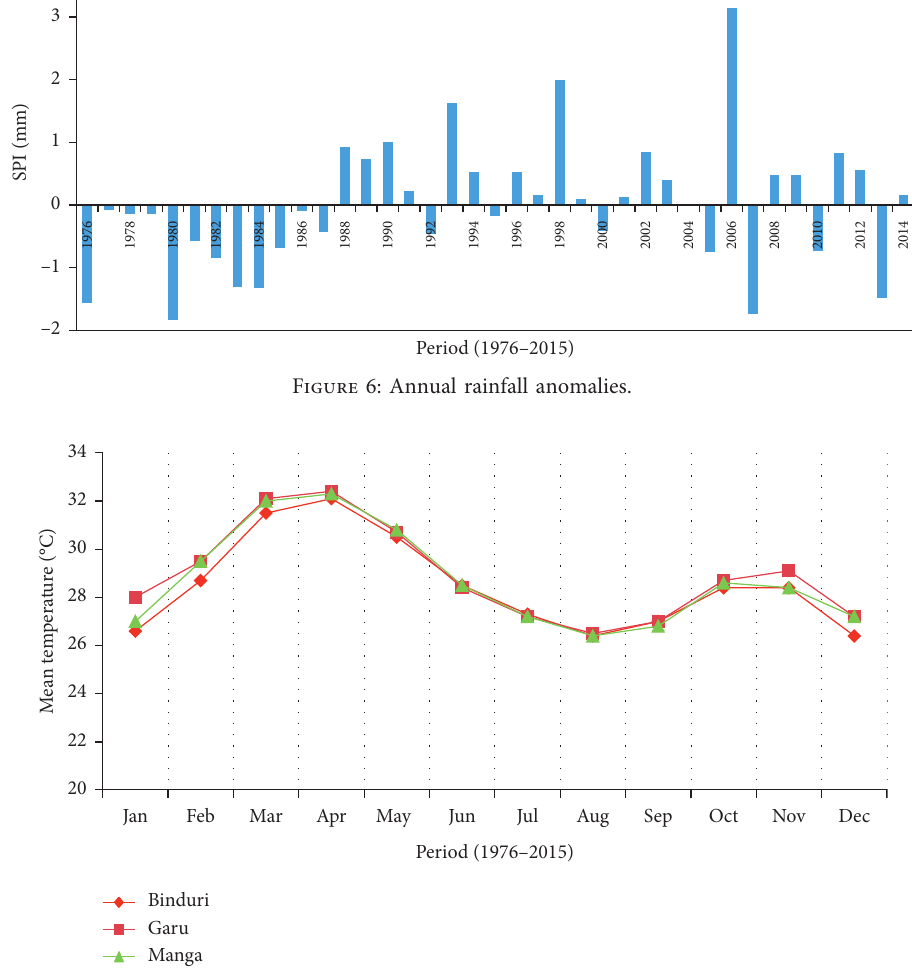
Figure 7: Monthly cycle of